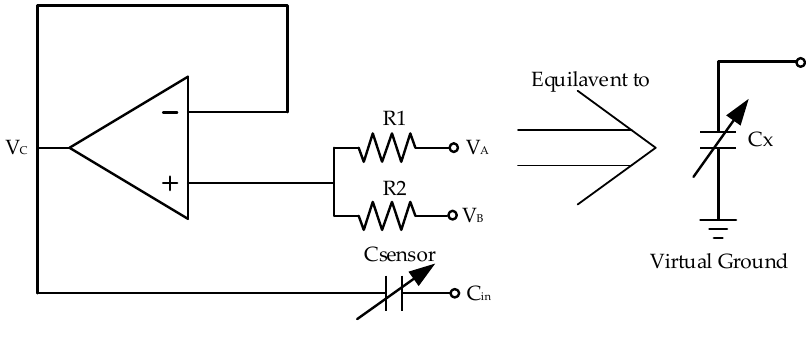
Figure 3. Scalable C x circuit.